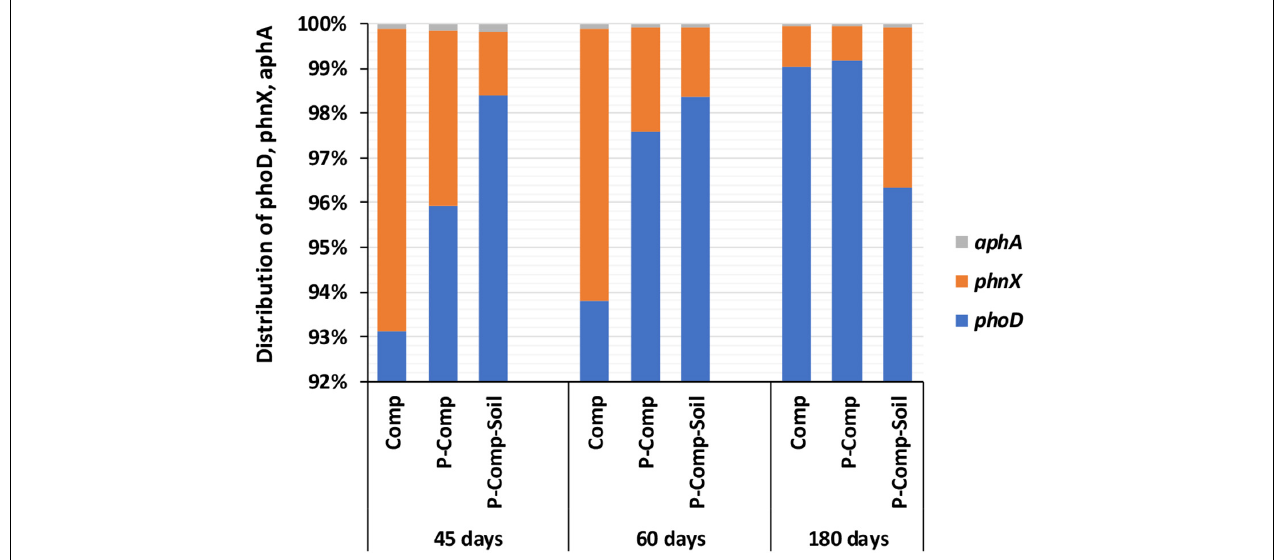
FIGURE 3 | Distribution of phoD , phnX , and aphA genes involved in P mineralization. Sampling was carried out at 45, 60, and 180 days. The data of each treatment at a given sampling period are averages of 3 replications per treatment. Comp, sole compost with sorghum straw as organic material; P-Comp, Burkina phosphate rock (BPR)-enriched compost; P-Comp-Soil, BPR-enriched composted with addition of rhizosphere soil; phoD, alkaline phosphatase; phnX, phosphonatase; aphA, acid